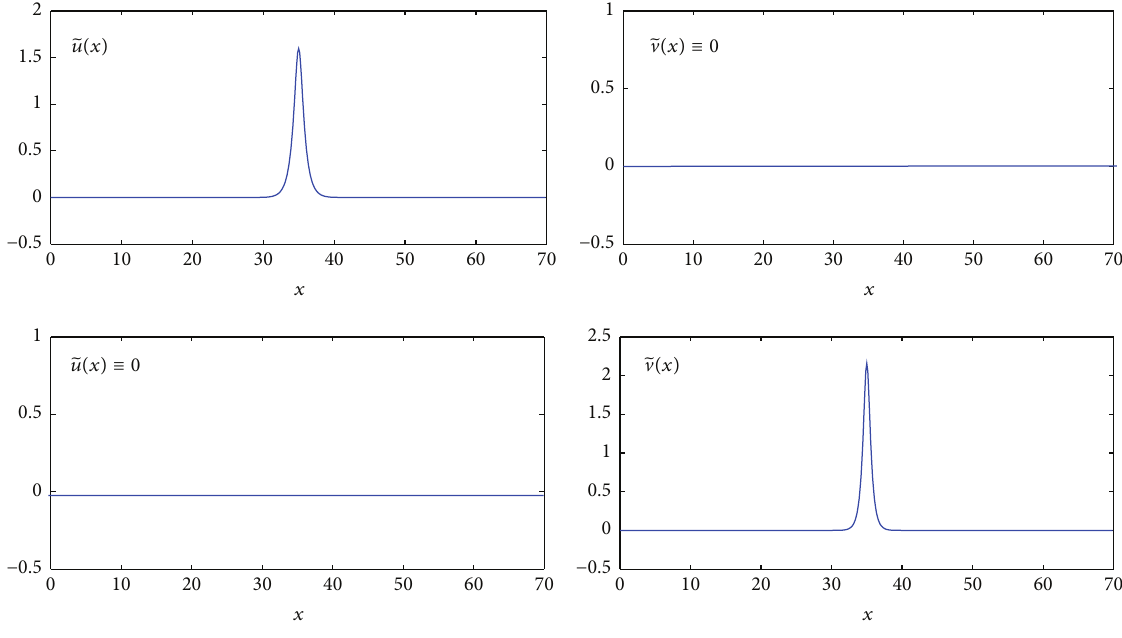
Figure 9: Single-mode solitons for system